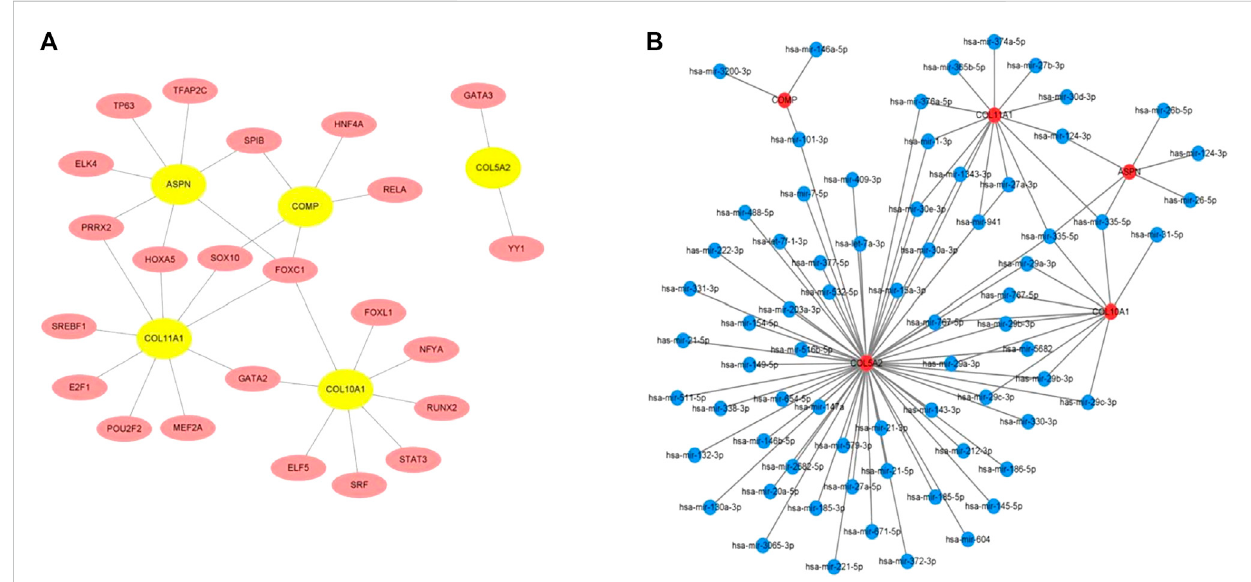
FIGURE 5 (A) TF – hub gene network established using the JASPAR database on NetworkAnalyst. (B) miRNA – hub gene network acquired utilizing miRTarBase v8.0 and TarBase v8.0 via